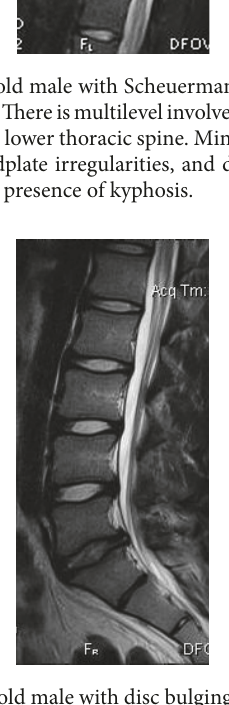
Figure 2: A 15-year-old male with disc bulging in the lower lumbar spine and a disc hernia at L5-S1 level, on sagittal T2WI.